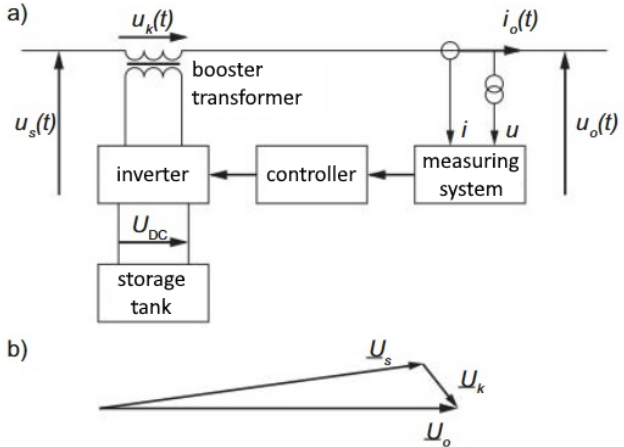
Figure 32. Series compensator [35]: ( a ) single-phase substitution diagram and ( b ) voltage indication diagram, where U o —receiver voltage, U z —mains voltage, and U k —compensator voltage.